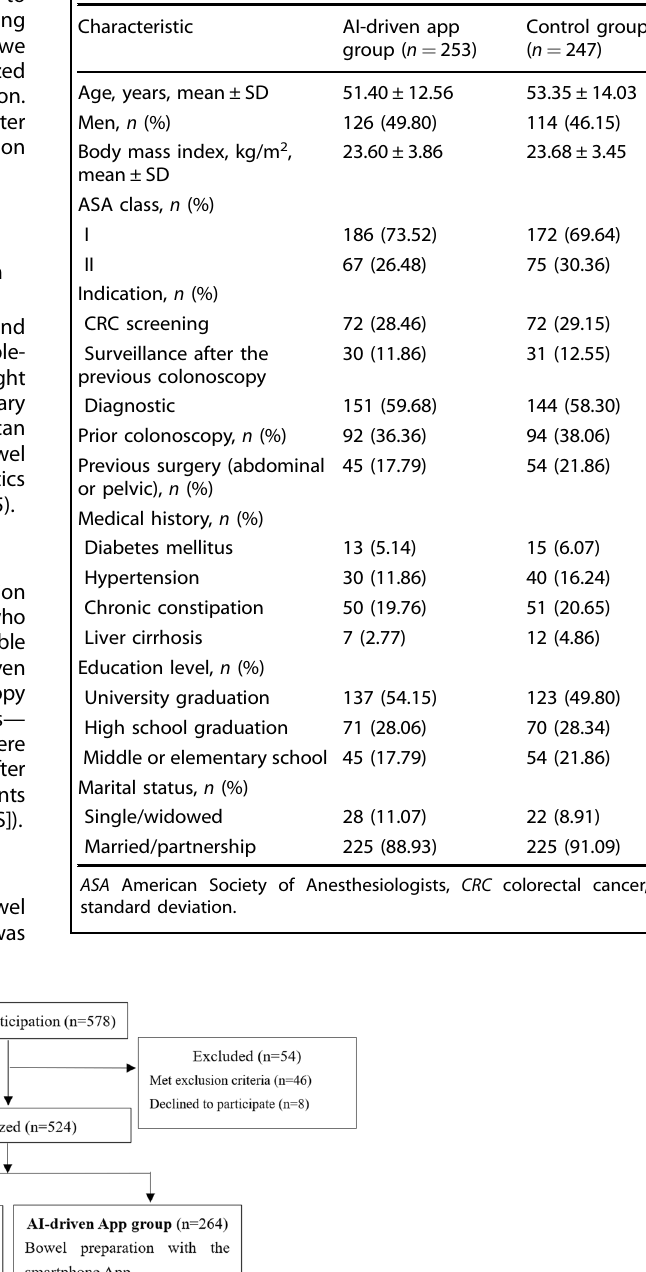
Table 1. Baseline characteristics of the total analysis population.